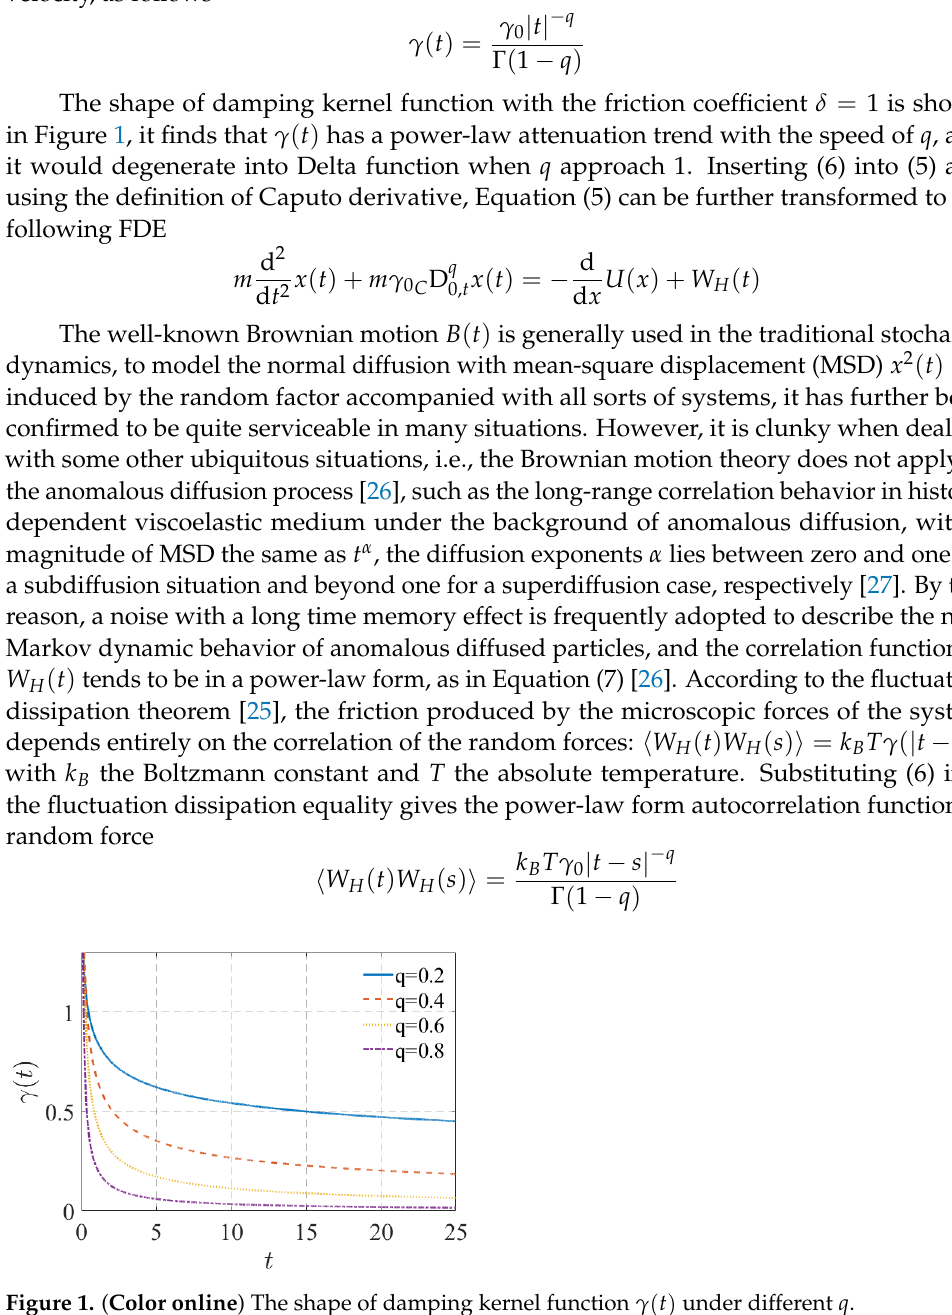
() t  under different q .